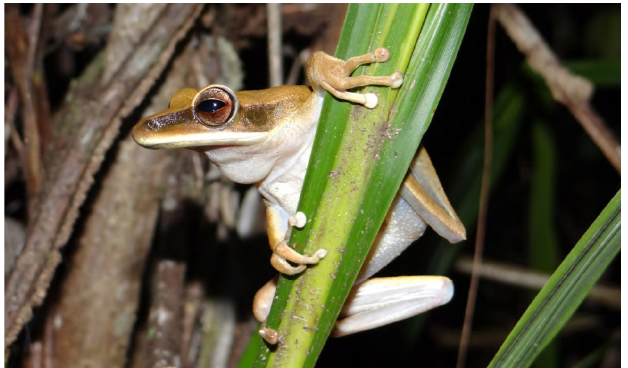
Hypsiboas lanciformis Figure 1. Adult (voucher specimen, male, snout- vent lenght SVL = 60.9 mm) from Ilha de Santana, municipality of Santana, Amapá state,